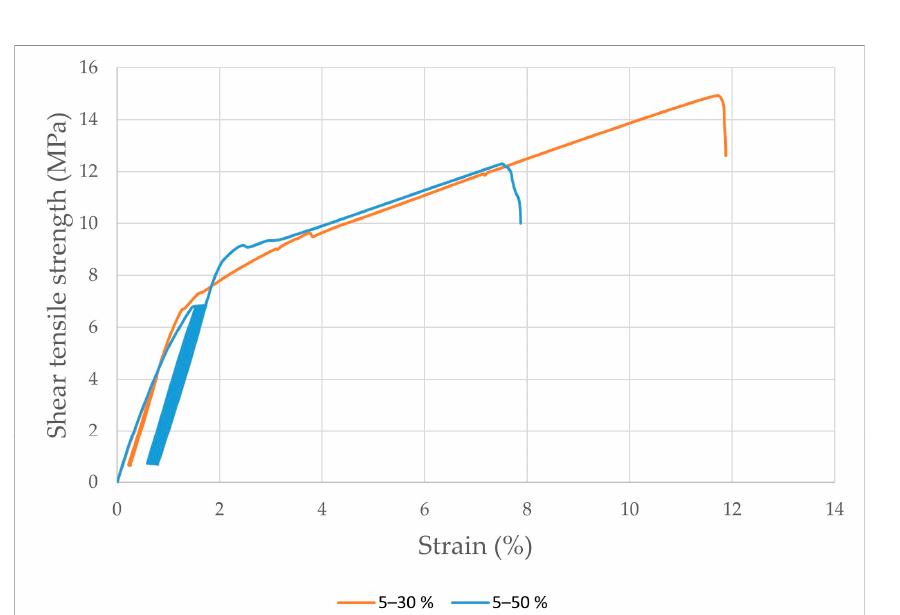
Table 6. Evaluation of the type of failure of individual types of adhesive bonds.